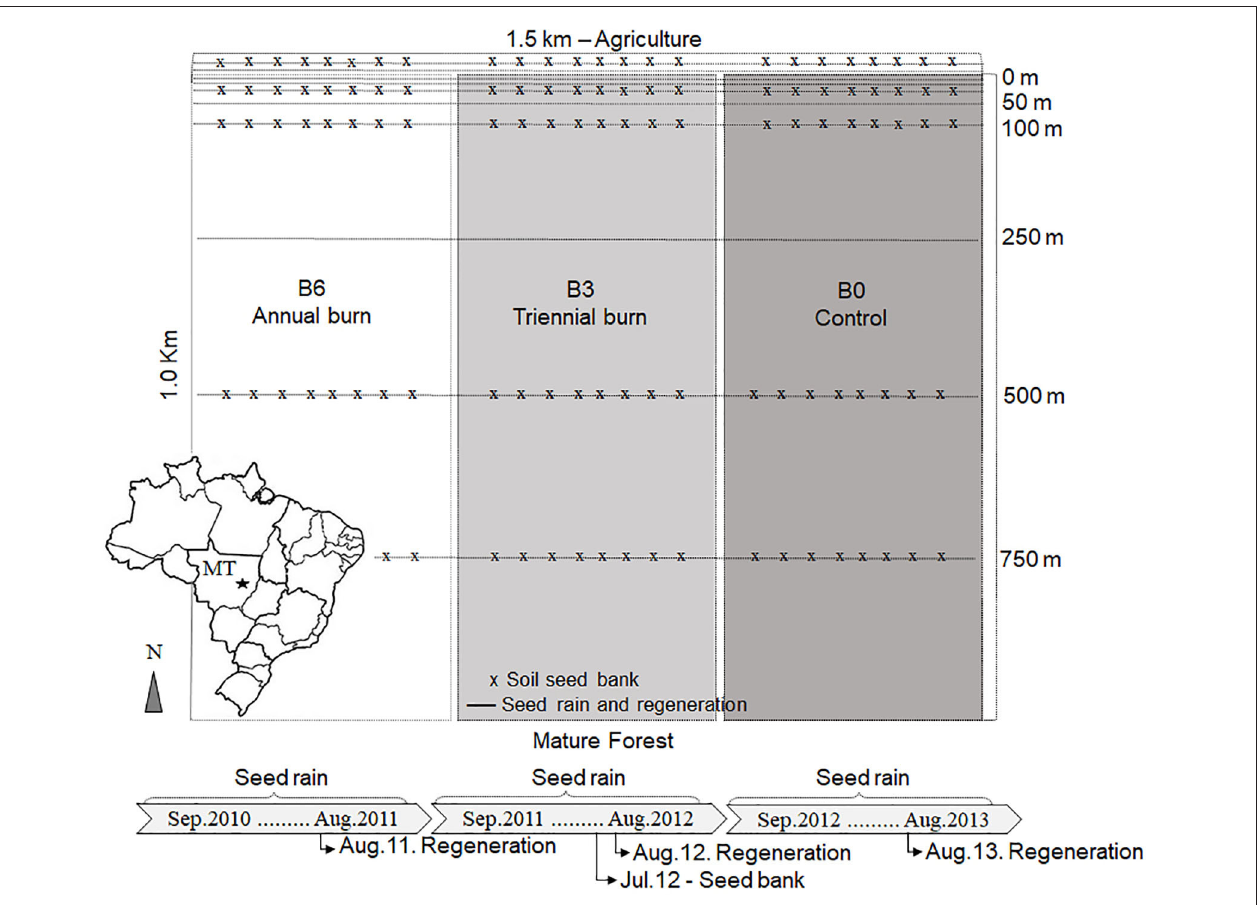
FIGURE 1 | Sampling design of a long-term fire experiment in Mato Grosso state, southeastern Amazon Basin. Lines indicate the regeneration plots and seed rain mesh traps distributed from agriculture edge to forest interior (0–750m). The “x” indicates soil seed bank sampling points. B0 (control ) was not burned, B3 was burned three times with 3 years interval, and B6 was burned annually, six